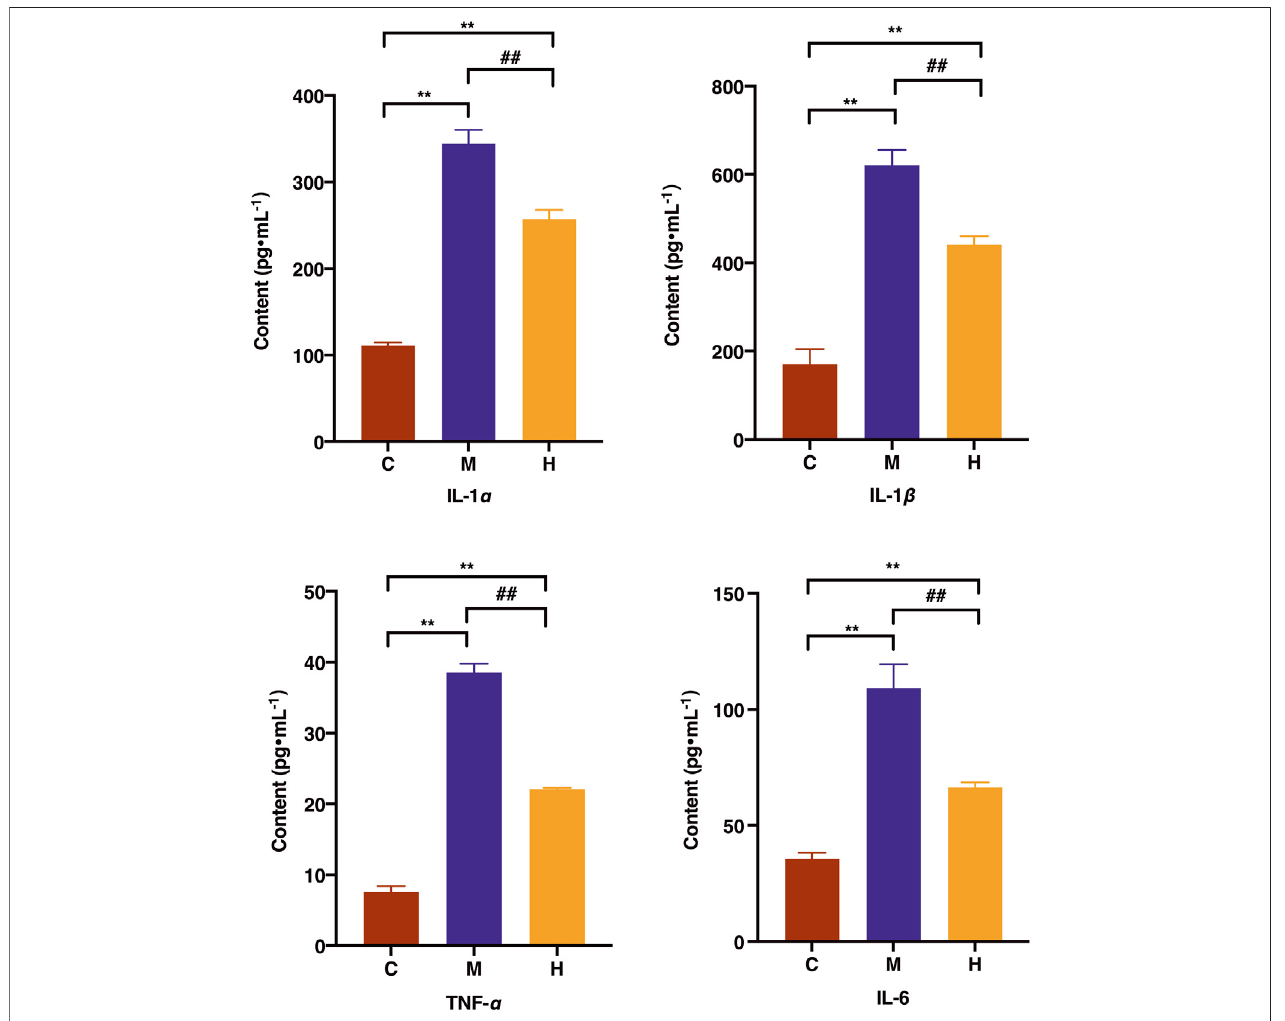
FIGURE 4 | Effects of HQT on the levels of IL-1 ɑ , IL-1 β , IL-6, and TNF- ɑ after 63 days of oral administration on CAC mice. C: normal control; M: model control; H: HQT control. Data are represented as the mean ± SD ( n = 10, (cid:1) x ± s ). * p < 0.05, ** p < 0.01 vs normal control; # p < 0.05, ## p < 0.01 vs. model control.